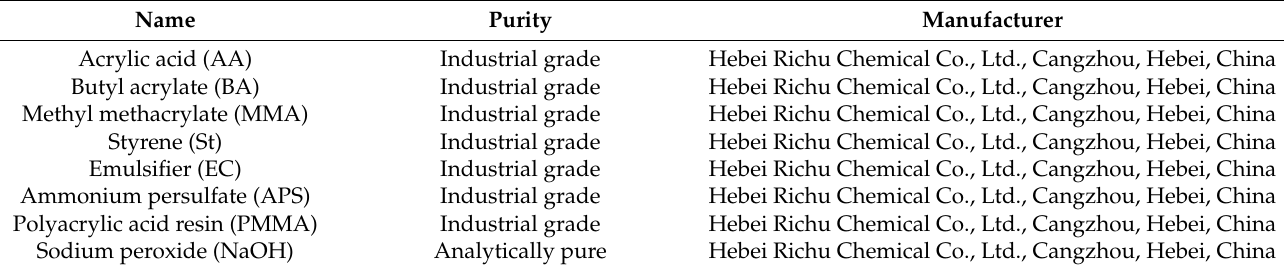
Table 1. Main experimental reagents.